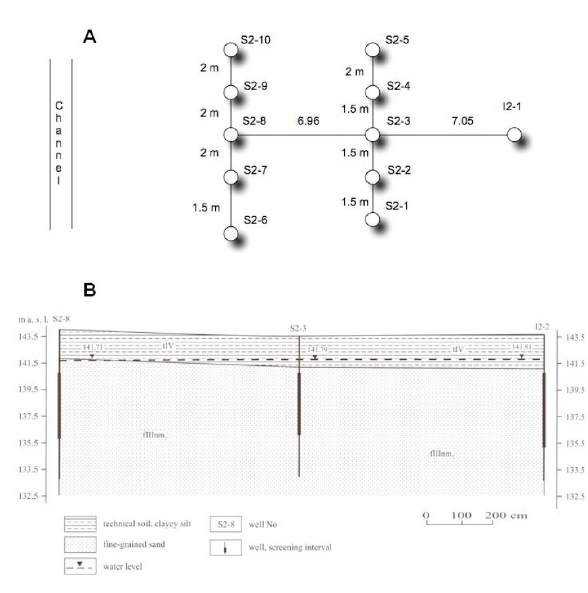
Figure 3: Scheme (A) and geological cross-section (B) of the second well